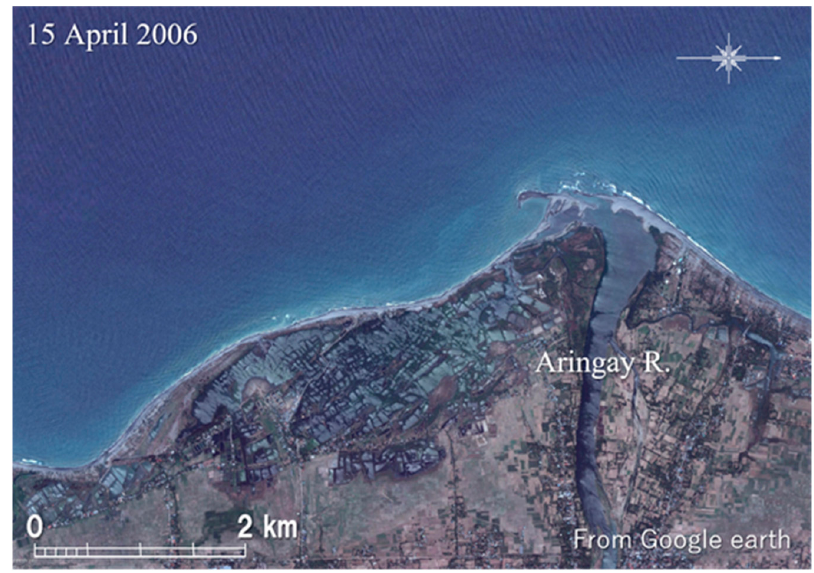
Figure 11. Satellite image of shoreline around Aringay River mouth (15 April 2016). By 28 October 2009, a slender sand spit elongated to a length of 770 m, while rotating counterclockwise and enclosing a lagoon behind the sand spit, although the shoreline north of the river mouth was stable (Figure 12).